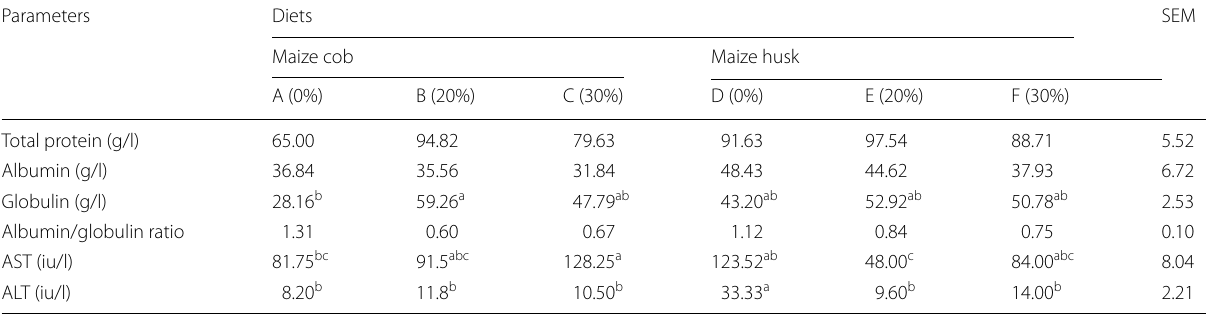
a, b, c means within the same row with different superscripts are significantly ( P < 0.05) different =